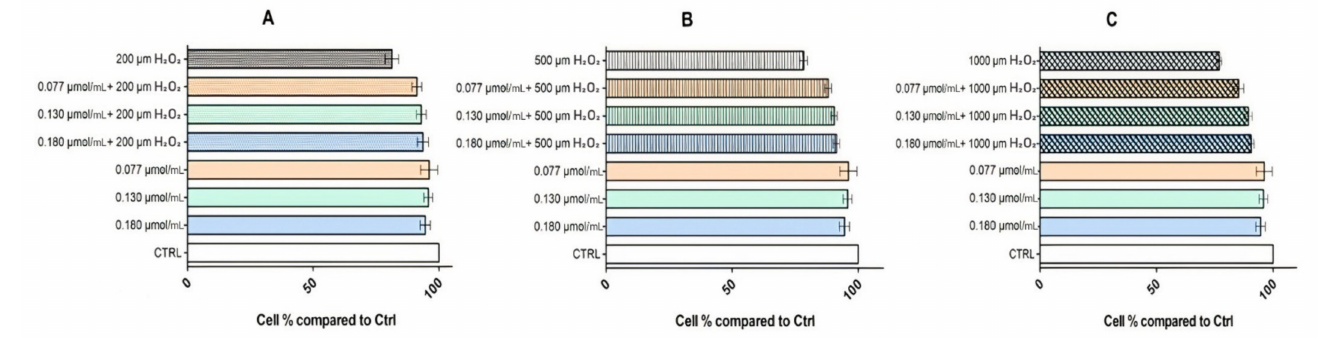
Figure 10. Effects of rhodoxanthin pretreatment on H 2 O 2 -induced HaCaT cells damage. Cell viability detected by MTT assay. HaCaT cells exposed to H 2 O 2 for 2 h. Significance: p < 0.0001 vs. control. HaCaT cells exposed to C1–C3 of rhodoxanthin for 24 h. Significance: p < 0.0010. ( A ) HaCaT cells exposed to C1–C3 and 200 µ m H 2 O 2 . Significance: p < 0.05. ( B ) HaCaT cells exposed to C1–C3 and 500 µ m H 2 O 2 . Significance: p < 0.05. ( C ) HaCaT cells exposed to C1–C3 and 1000 µ m H 2 O 2 . Significance: p <